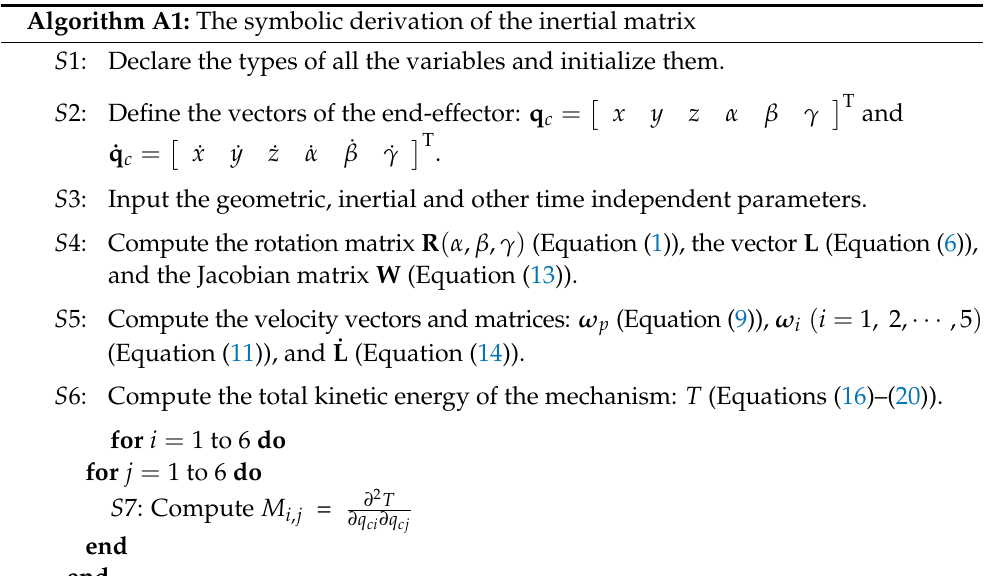
Algorithm A1: The symbolic derivation of the inertial matrix